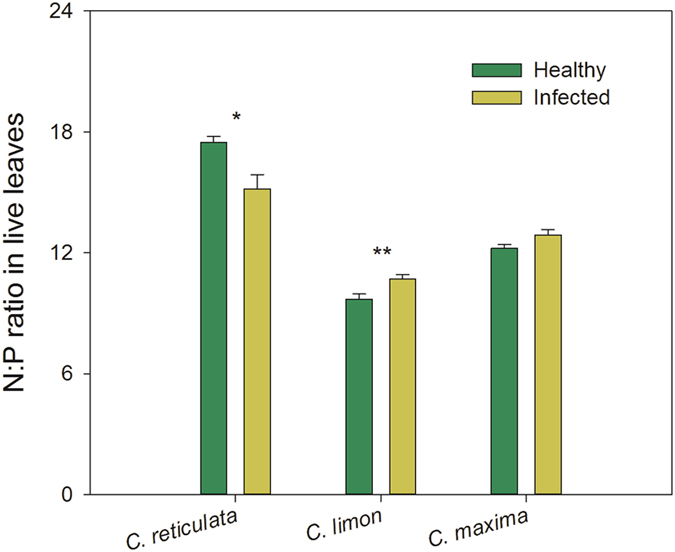
N:P ratios in live leaves of different citrus species.There were no significant differences in N:P ratio between sampling dates for all species, therefore the N:P ratios in June and October were compiled to calculate means ± Se (n = 10) for each species. * and ** above bars indicate significant differences at P < 0.05 and 0.01, respectively, derived from the results of paired t-tests.